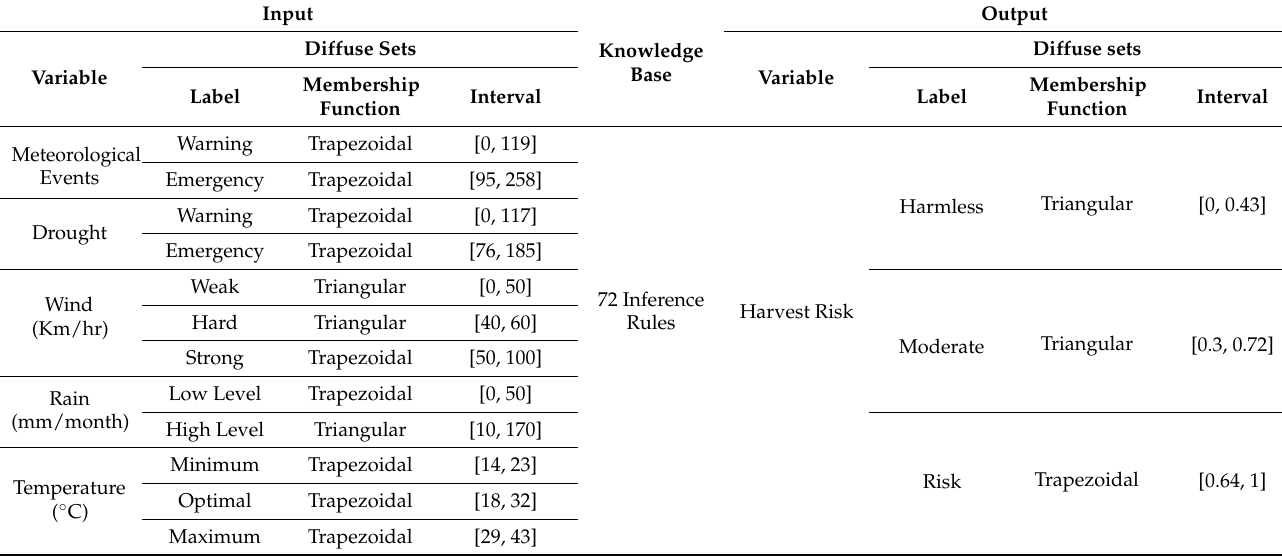
Table A2. Uncertain parameters model: fuzzy sets and operation